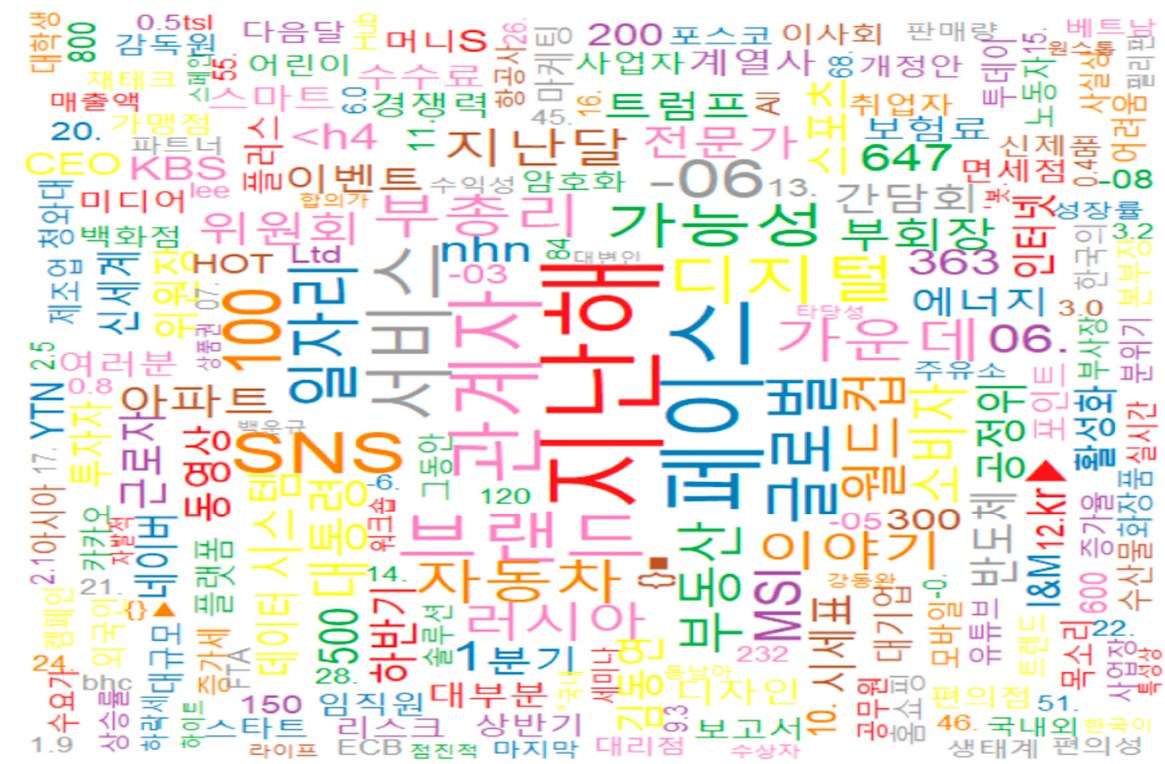
Figure 14. Big data visualization of terms frequently appearing in the “social” category. Table 1. Translation of the big data visualization of the Top 40 categories.